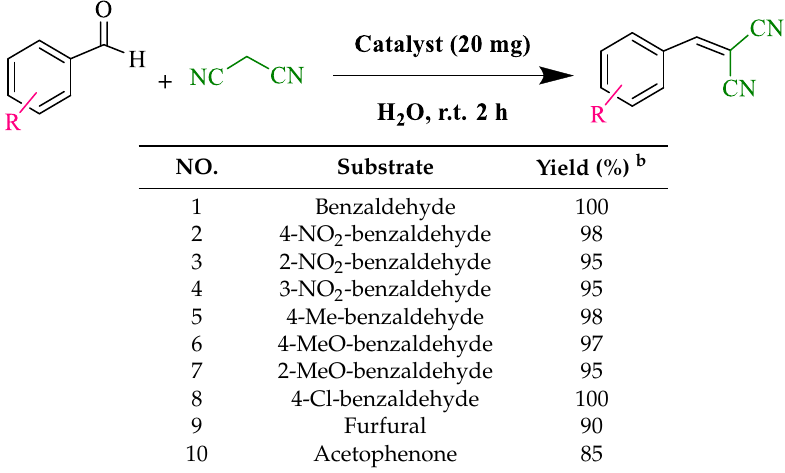
Table 2. The comparison of BC@GCN-P-IL-based procedure for the model Knoevenagel condensation reaction (malononitrile and benzaldehyde) with some reported ones